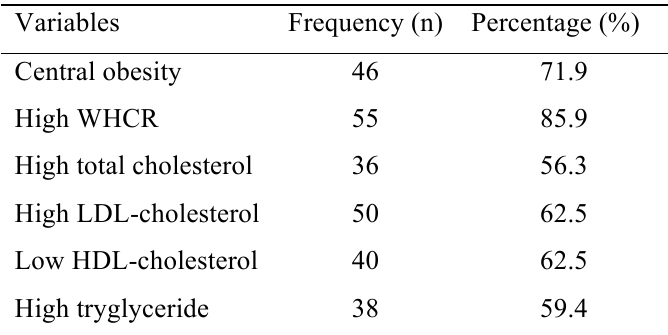
Table 2 Distribution of the subjects based on central